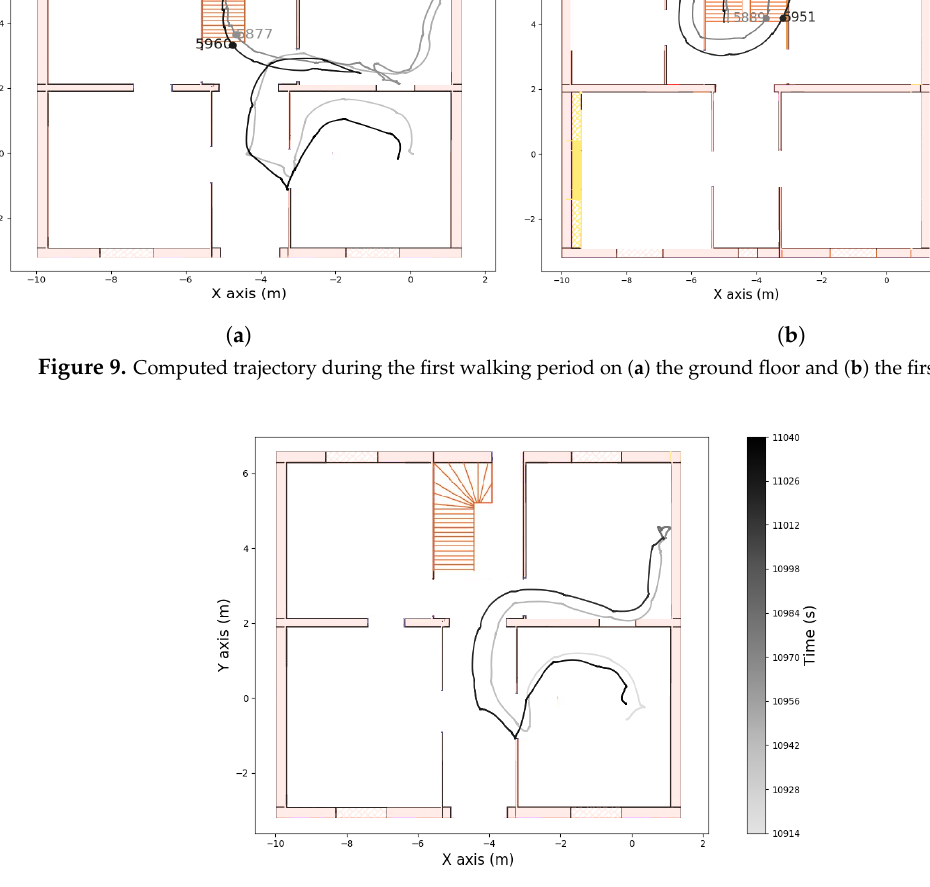
Figure 10. Computed trajectory during the second walking period on the ground floor.